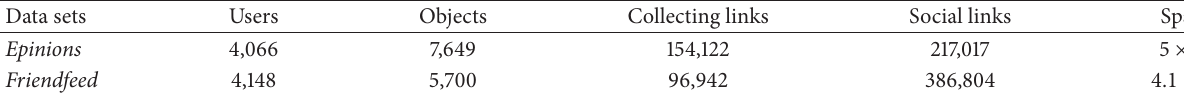
Table 1: Properties of the tested data sets.